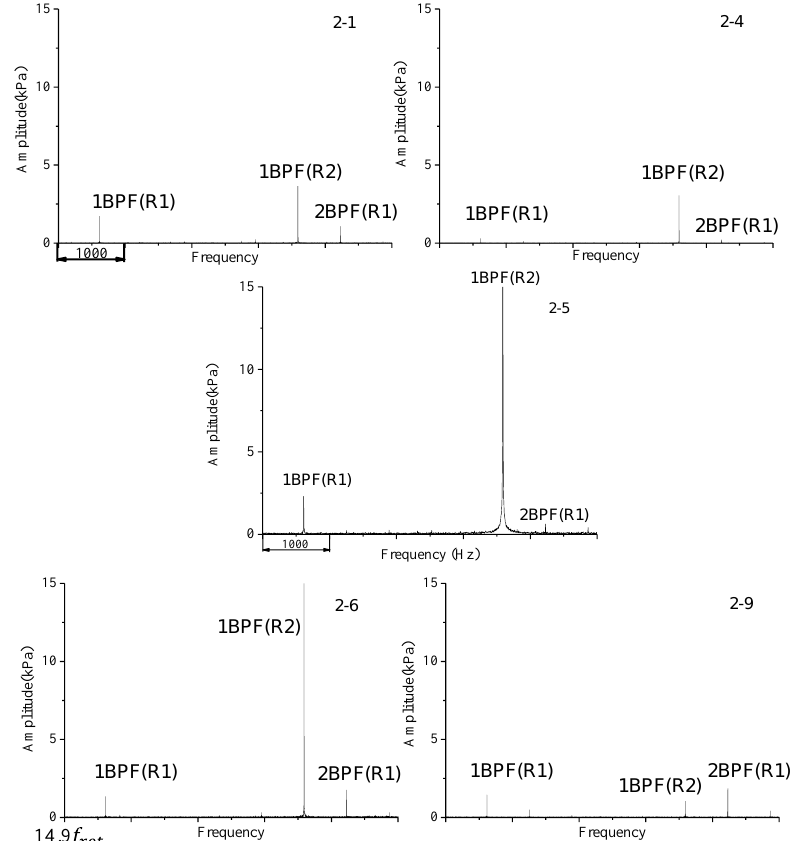
Figure 6. The change in the spectrum of R2 pressure fluctuation near the design point, from experimental results .